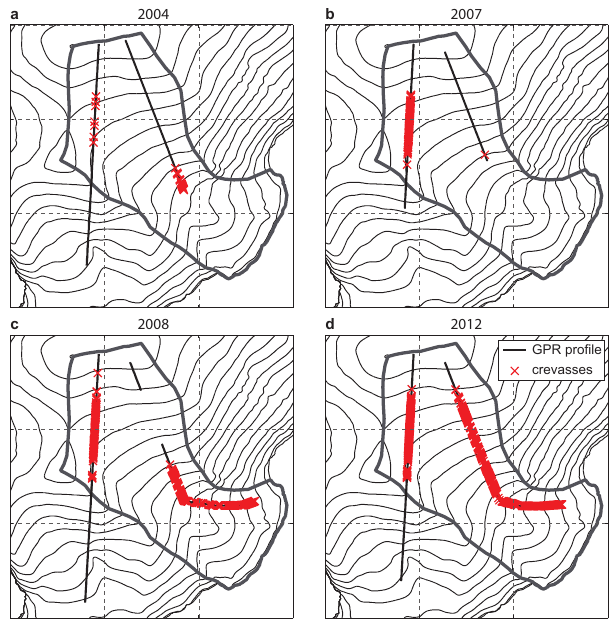
Figure C1. Crevasse formation on upper Basin-3 in 2004–2012 in- ferred from GPR. GPR profiles are plotted in solid black, detected crevasses are marked as red crosses. The outline of Basin-3 is shown in dark